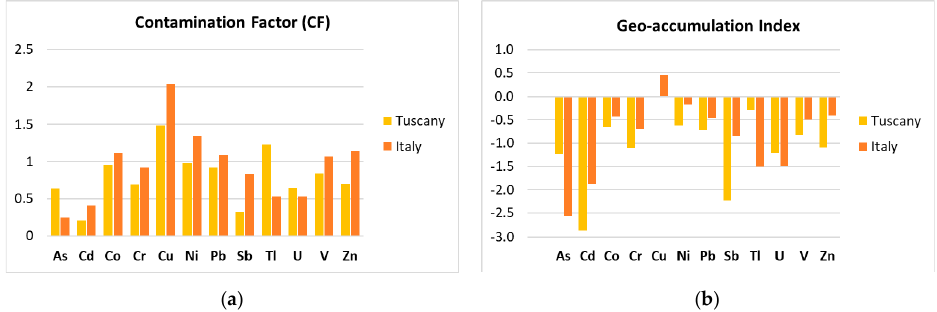
Figure 1. Contamination factor ( a ) and Geo-accumulation Index ( b ) of PTEs (average values) in the AdV cultivation soils in the Valdichiana area, calculated using their background levels in soils of Southern Tuscany [22,23] and Italy [24].